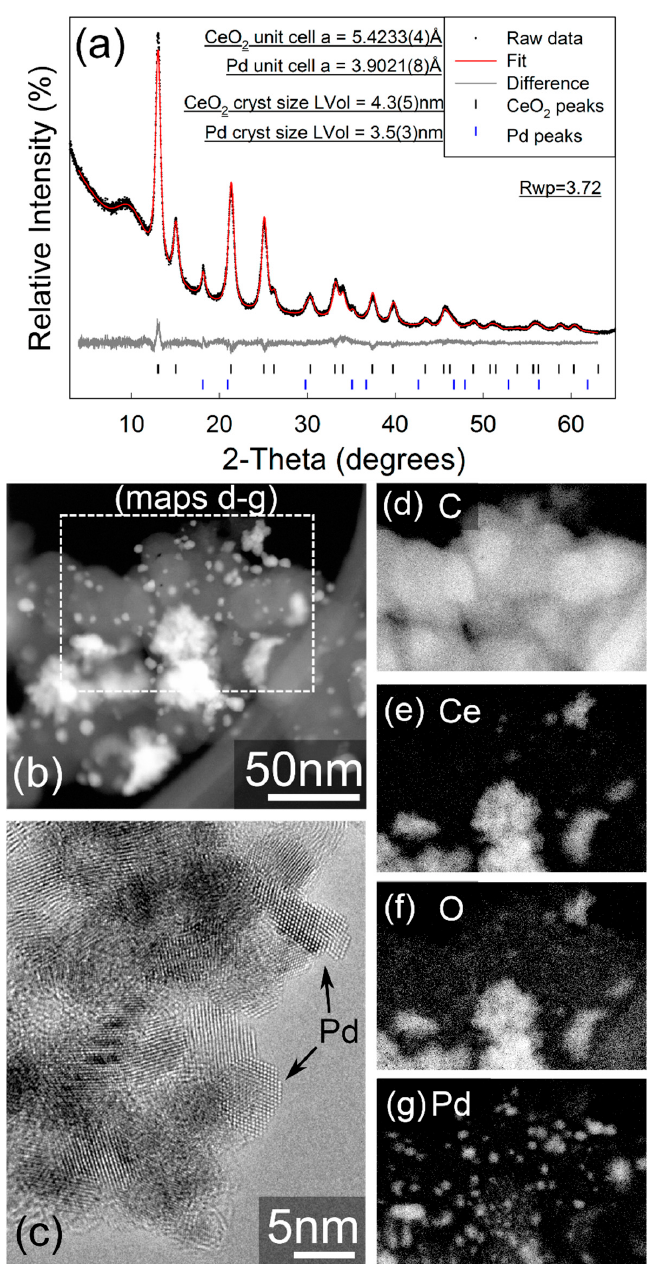
Figure 2. ( a ) Fitted X-ray powder diffractogram for Pd/C-CeO 2 . Data were collected in capillary transmission mode using a Mo-K α source and modelled using a Rietveld-type approach. The “amorphous bump” at approx. 9° 2 θ is due to the Kapton capillary material. ( b ) Annular dark-field STEM image, ( c ) high-resolution TEM image showing crystalline Pd particles, ( d – g ) elemental EDX images acquired within the area indicated in ( b ). Gamma adjustments were applied in ( b,d – g